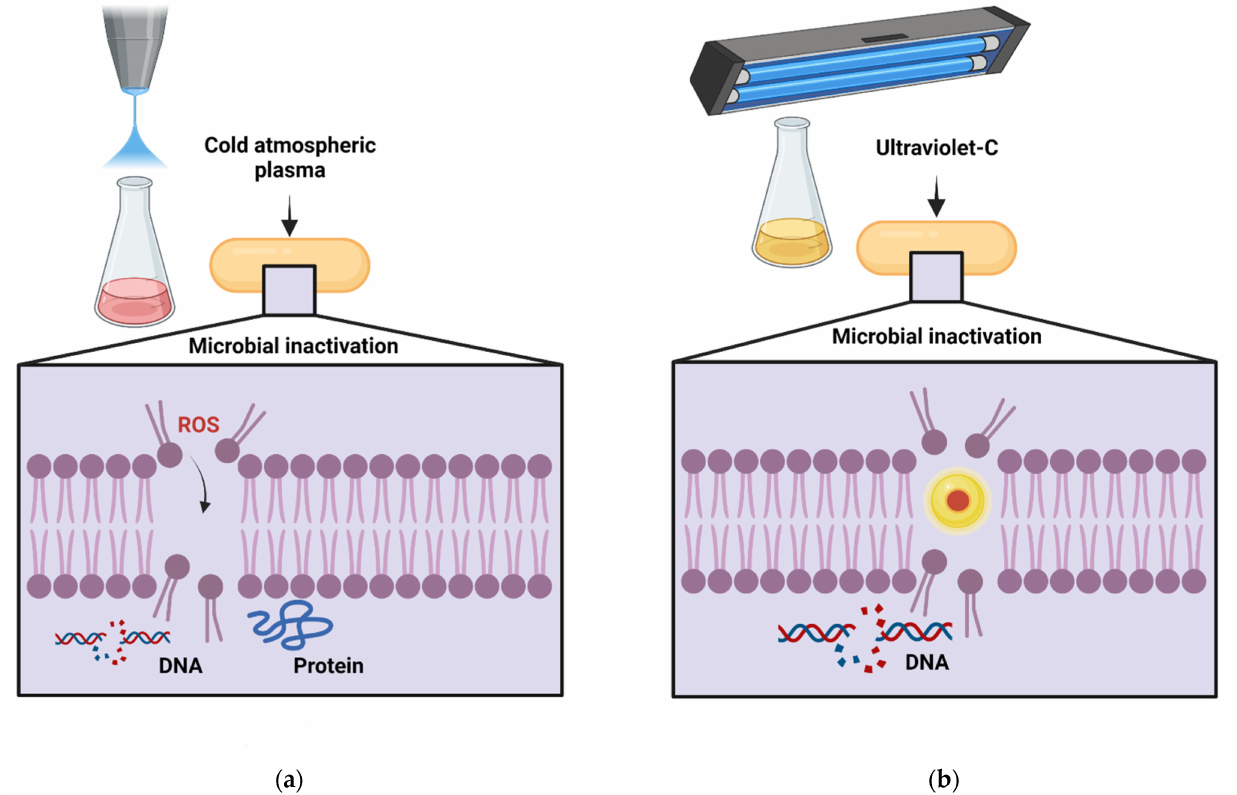
Figure 4. Mechanisms of microbial inactivation of ( a ) cold atmospheric plasma and ( b ) ultraviolet-C light on microbial inactivation [100,101] (Created with BioRender.com; accessed on 30 March 2022). DNA: Deoxyribonucleic acid, ROS: Reactive oxygen